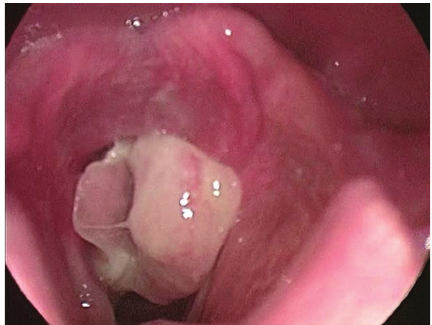
Figure 4: Postintubation granuloma.